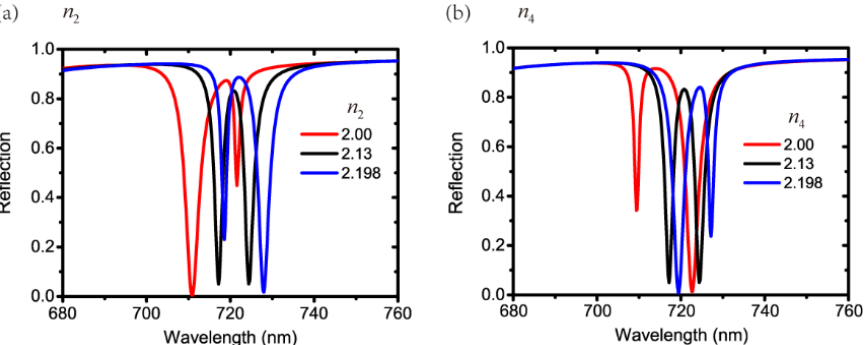
Figure 6. Reflection spectra with different ( a ) n 1 , ( b ) n 3 and ( c ) n 5 . Afterwards, the influences of n 2 and n 4 on the EIT-like effect are investigated, as shown in Figure 7a,b. The refractive index of 2.13 denotes the TiO 2 material employed in layer 2 and layer 4 in the previous discussions. Additionally, the refractive indices of 2.00 and 2.198 represent the material of Si 3 N 4 and Ge-doped SiO 2 , respectively. Whether we increase n 2 or n 4 , the wavelength of the waveguide resonance in layer 2 or layer 4 redshifts according to Equations (4) and (5). The waveguide resonance in layer 2 redshifts with n 2 = 2.198 compared with that of n 2 = 2.13. Therefore, a redshifted waveguide resonance in layer 2 and an unchanged waveguide resonance in layer 4 form a Fano resonance on the left falling edge, as seen in the blue curve in Figure 7a. For n 4 = 2.198, the waveguide resonance in layer 4 redshifts compared with that of n 4 = 2.13. A redshifted waveguide resonance in layer 4 and an unchanged waveguide resonance in layer 2 form a Fano resonance on the right falling edge, as seen in the blue curve in Figure 7b. Through the same way of analyzing, the simulated results with n 2 = 2.00 and n 4 = 2.00 can also be understood.